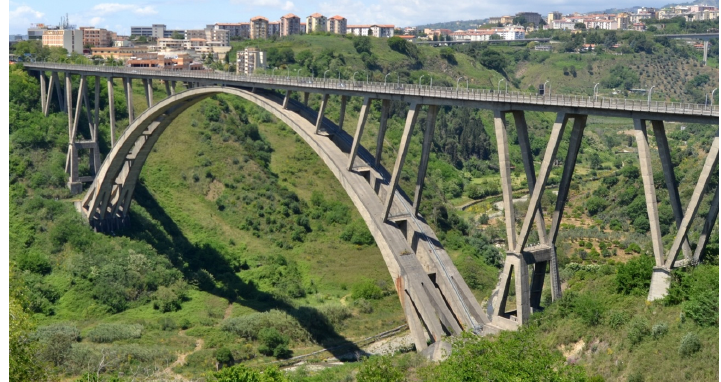
Figure 3. Morandi Bridge (Catanzaro, Italy).